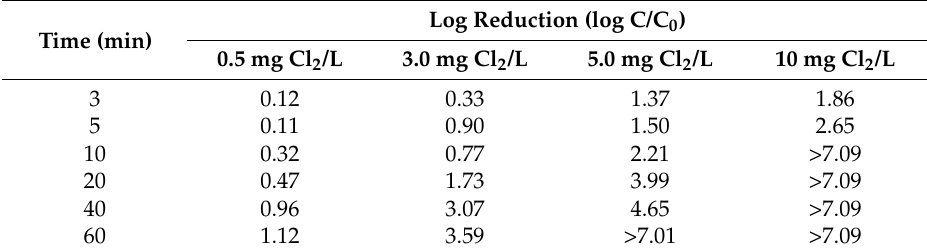
Figure 2. Changes of enterococci concentration (VRE suspended in secondary effluent). Table 3. Log reduction value in each initial chlorine concentration and stirring time (VRE suspended in secondary effluent).